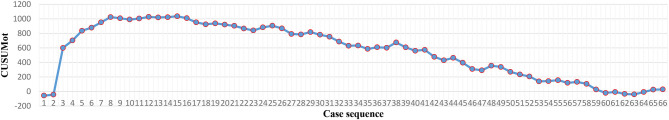
Cumulative sum graph for operative time for Prof. Li.